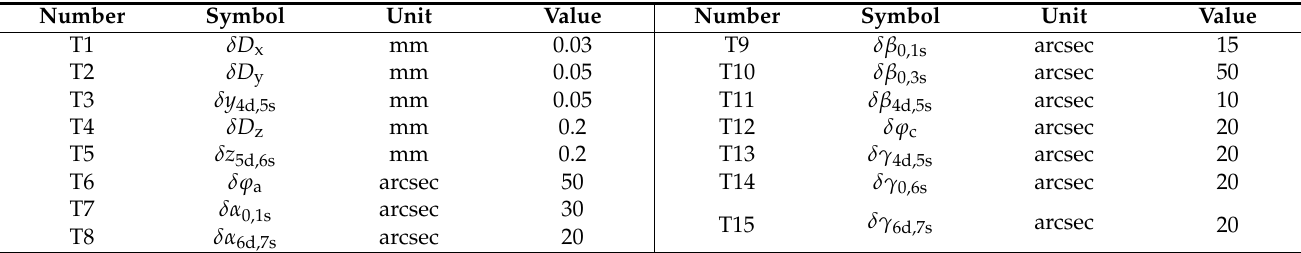
Table 4. Assembly errors of the optimized distribution for the profile grinding system.